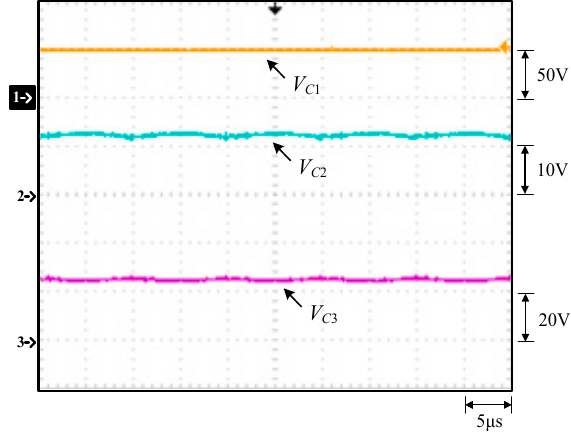
Figure 16. Measured waveforms at rated load: (1) v gs 2 ; (2) v ds 2 ; (3) v gs 4 ; (4) v ds 4 . Energies 2019 , 12 , x FOR PEER REVIEW